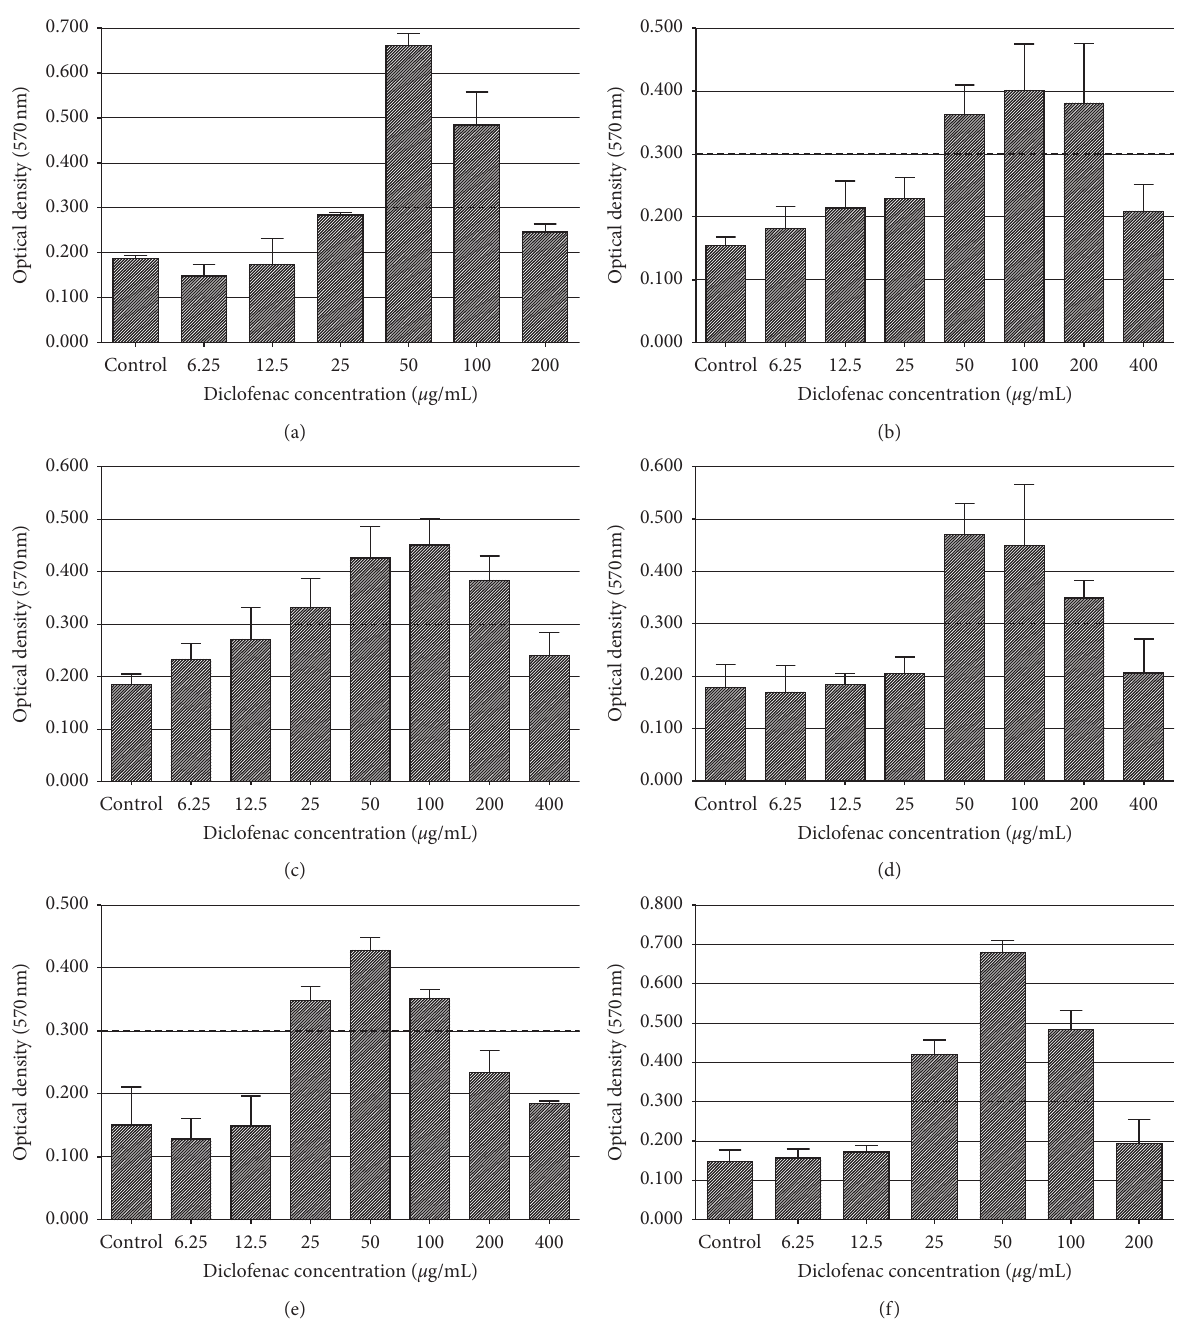
Figure 1: Biofilm production by six (a–f) isolates of S. aureus in tryptone soy broth (TSB) added of subinhibitory concentrations of diclofenac. The horizontal dashed line indicates the cutoff value that separates production from nonproduction of the biofilm. Assays were repeated three times with similar results, and error bars represent mean with range. (a) A108. (b) A112. (c) A139. (d) B103. (e) B105. (f)